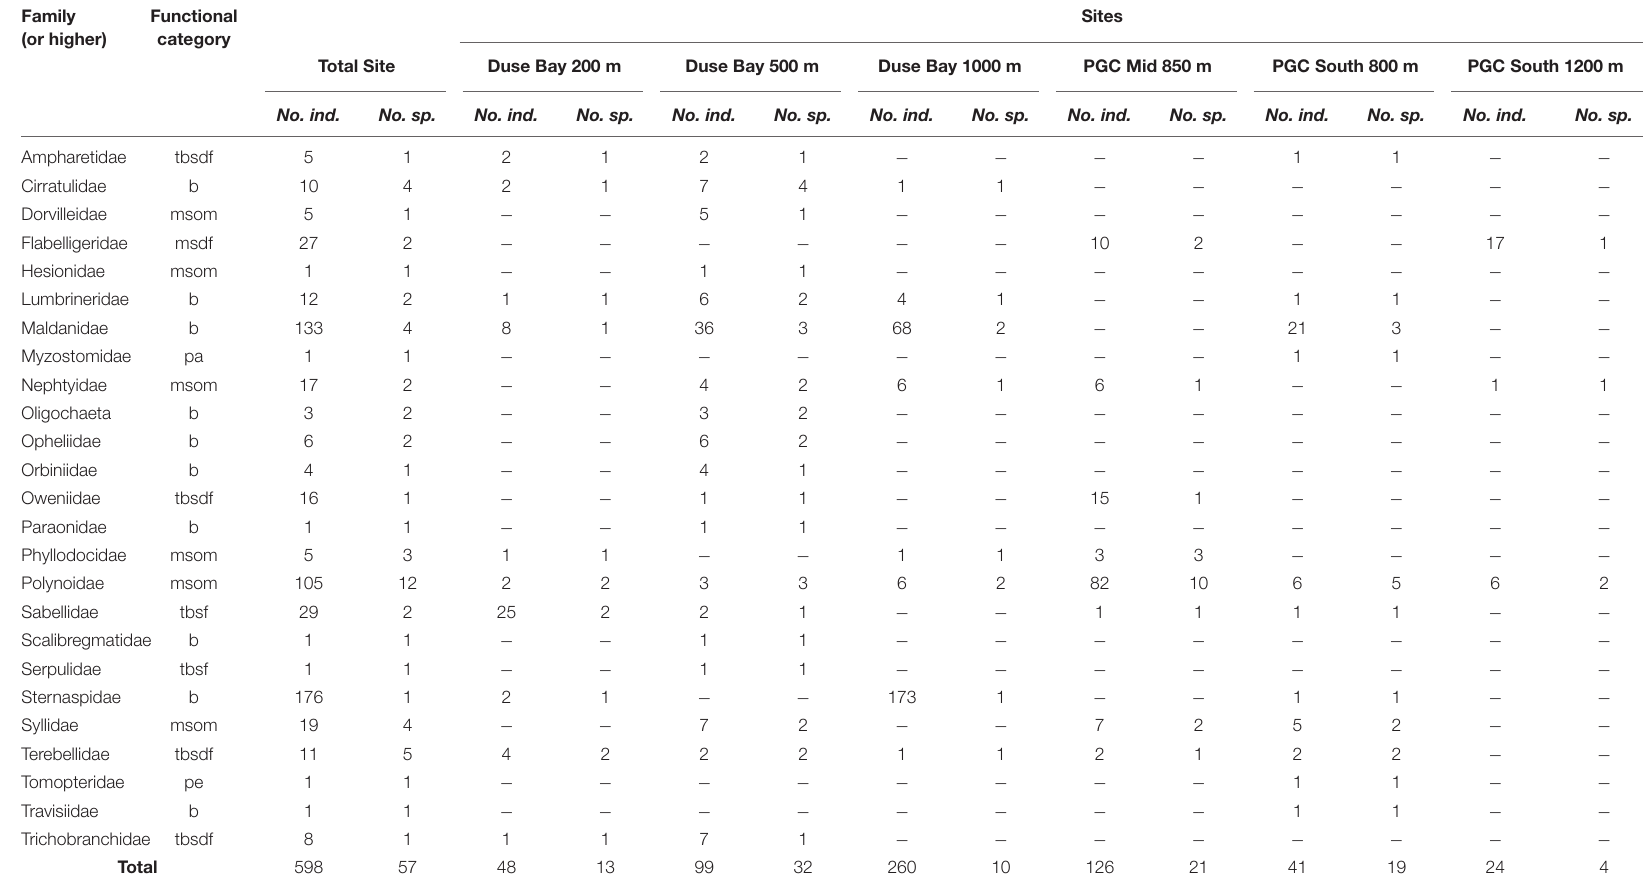
TABLE 2 | Number of individuals and morphospecies per polychete family (or higher taxonomic rank in the case of oligochaeta) sampled during cruise JR17003a. Family (or